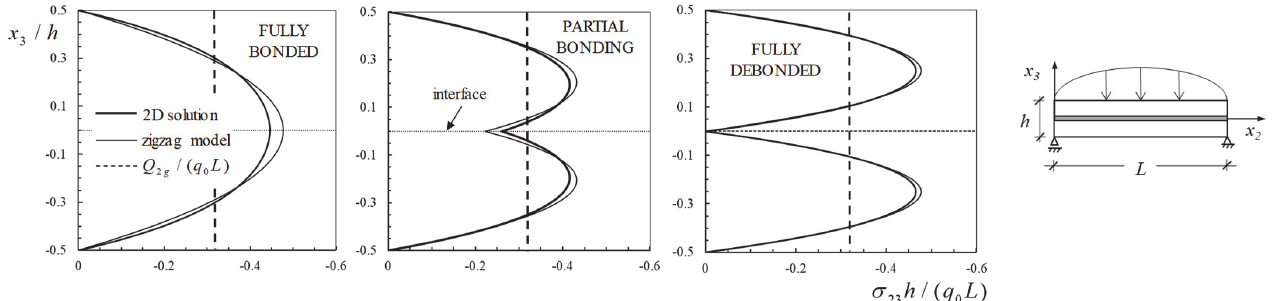
Figure 3: Dimensionless transverse shear stresses shown through thickness at 2 x L  in the thick unidirectionally reinforced wide plate with two layers and one imperfect interface shown on the right. The plate is subjected to a sinusoidal transverse load,